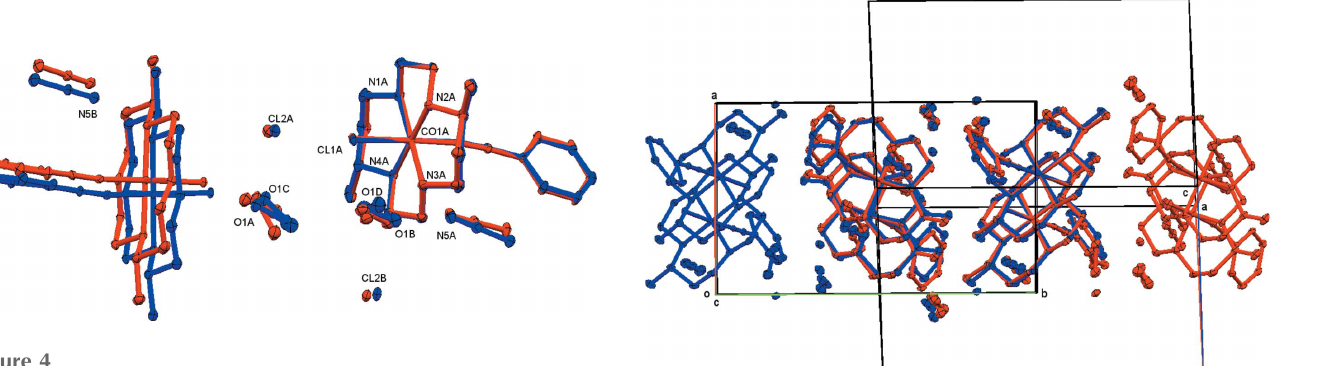
Figure 4 Least-squares overlay of one set of cations A and B (to the right) of compound 1 . Also shown are the surrounding chloride anions and solvate molecules and a second cation (on the left). Atoms color coded red belong to the original structure and atoms in blue were inverted prior to the least-squares overlay. The least-squares fit is based on all atoms of the cation pair on the right (r.m.s. deviation = 0.138 A˚ ). For this pair, labels are shown only for the A cation. Labels for atoms of the second pair of cations and for all carbon atoms are omitted for clarity.